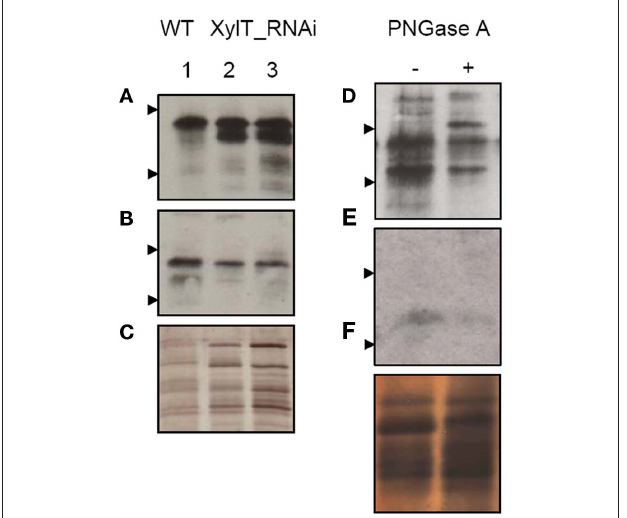
FiguRe 7 | immunoblot analysis of hymenoptera allergic patients. Immunoblots of tomato red fruits extracts were incubated with selected sera from hymenoptera allergic patients (see Table 1 ) V 008 (A) and V 011 (B) and developed for detection of human IgE. (C) Protein staining with silver as